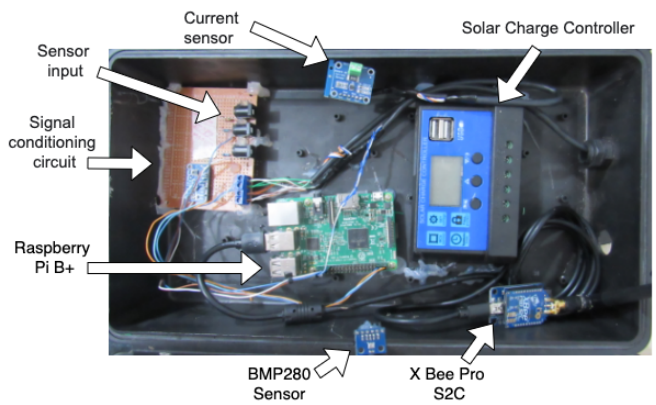
Figure 4. WTIM developed in the